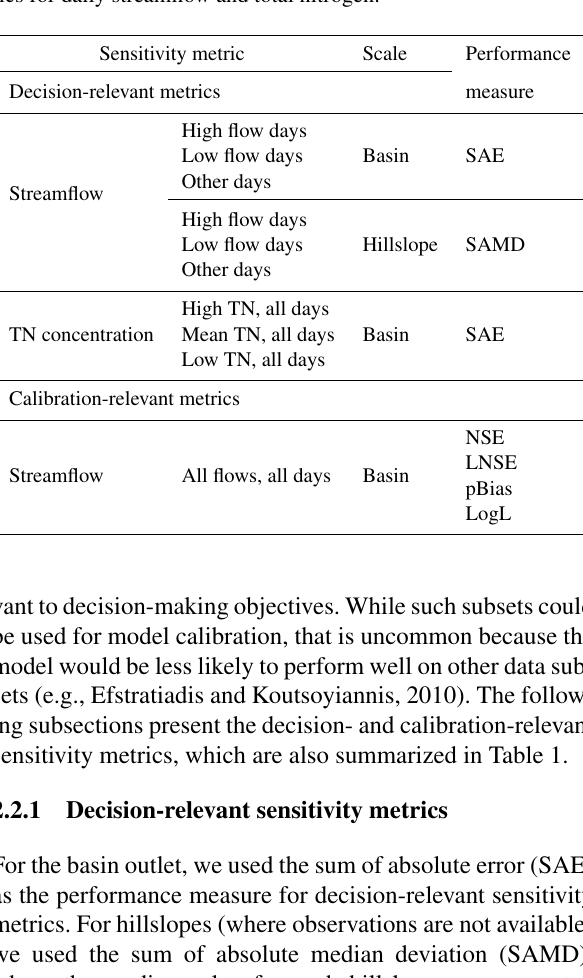
Table 1. Decision-relevant and calibration-relevant sensitivity met- rics for daily streamflow and total